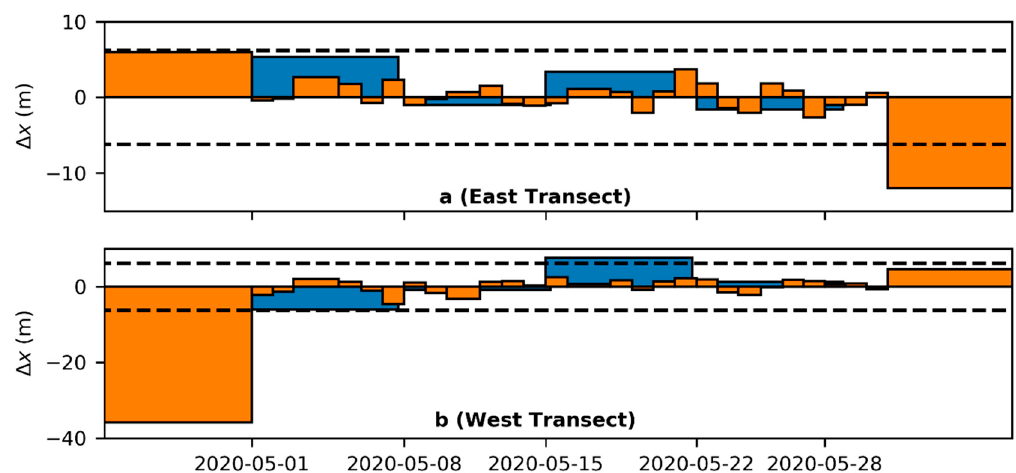
Figure 6. Shoreline change time series at ( a ) the east transect and ( b ) the west transect (red lines in Figure 5) calculated between every available observation (orange) and weekly differences in May (blue). Bar edges are at dates used to calculate the value for that bar. Observational uncertainty shown with black dashed lines. Note that the first and last orange bars extend along the x -axis from/to 5 March 2020 and 1 August 2020, respectively.